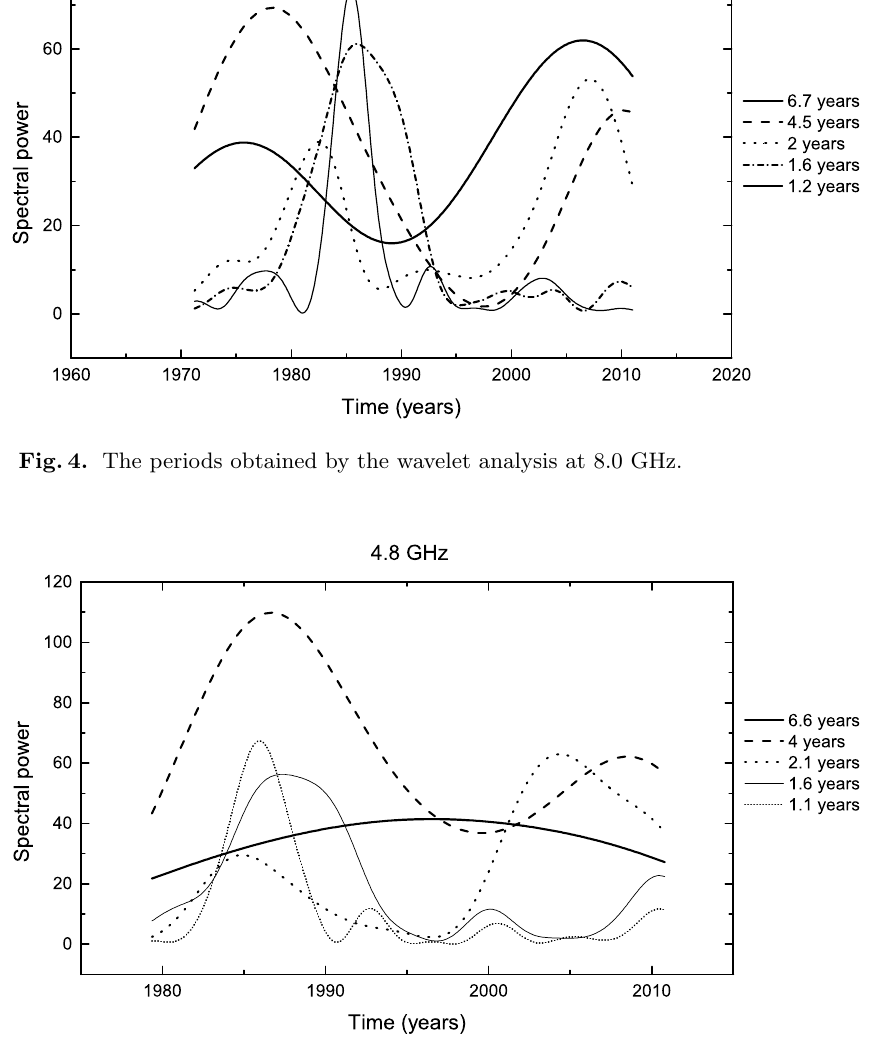
Fig. 5. The periods obtained by the wavelet analysis at 4.8